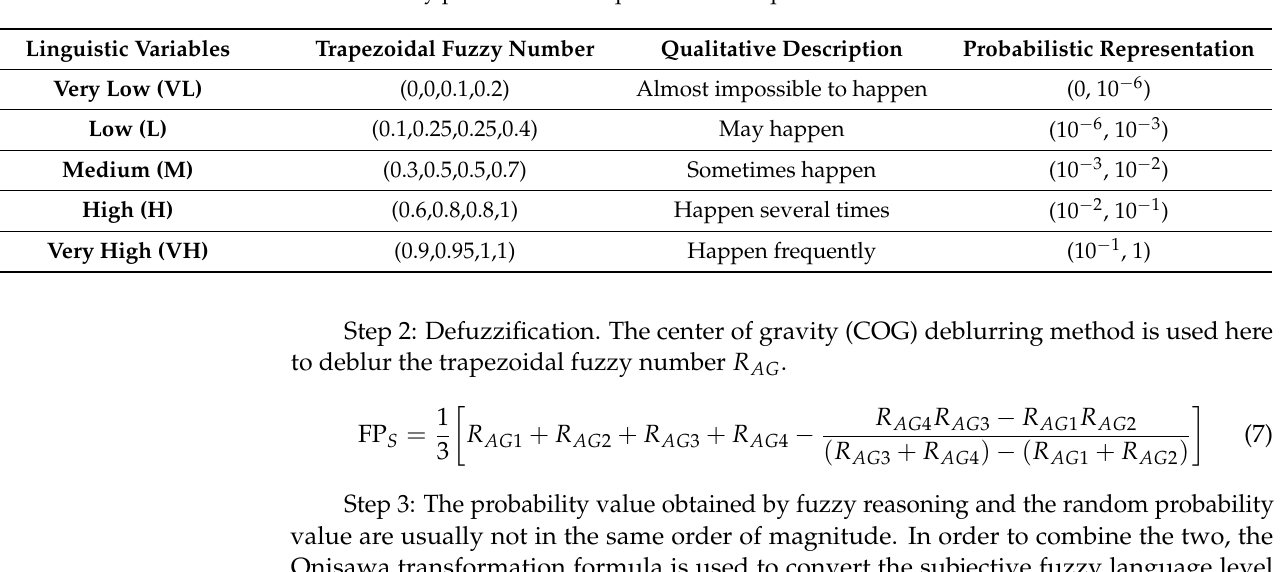
Table 1. Fuzzy possibilities and qualitative and quantitative